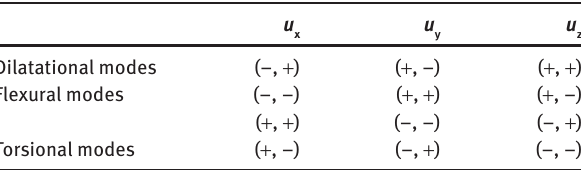
Table 1: Classification of normal modes of a nanowire according to the parity of the